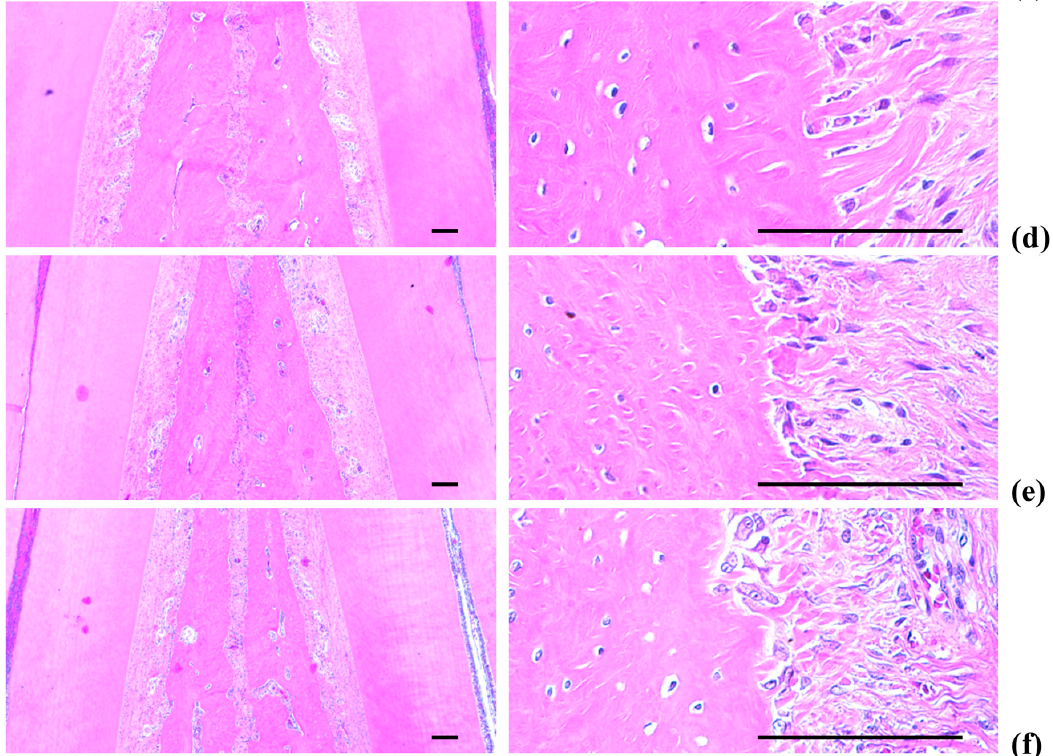
Figure 10. Representative histological images of alveolar bone areas between the upper incisor teeth, taken from Intact or EPD rats around upper left incisor teeth: ( a ) Intact control (Normal control, non-ligated and distilled water topically applied rats); ( b ) EPD control (Ligated EPD induced and distilled water topically applied rats); ( c ) IND (Ligated EPD induced and indomethacin 5 mg/kg orally administered rats); ( d ) Polycal-H (Ligated EPD induced and Polycal 50 mg/mL solution topically applied rats); ( e ) Polycal-M (Ligated EPD induced and Polycal 25 mg/mL solution topically applied rats); and ( f ) Polycal-L (Ligated EPD induced and Polycal 12.5 mg/mL solution topically applied rats). All H & E stain. Scale bars = 120 μ m.